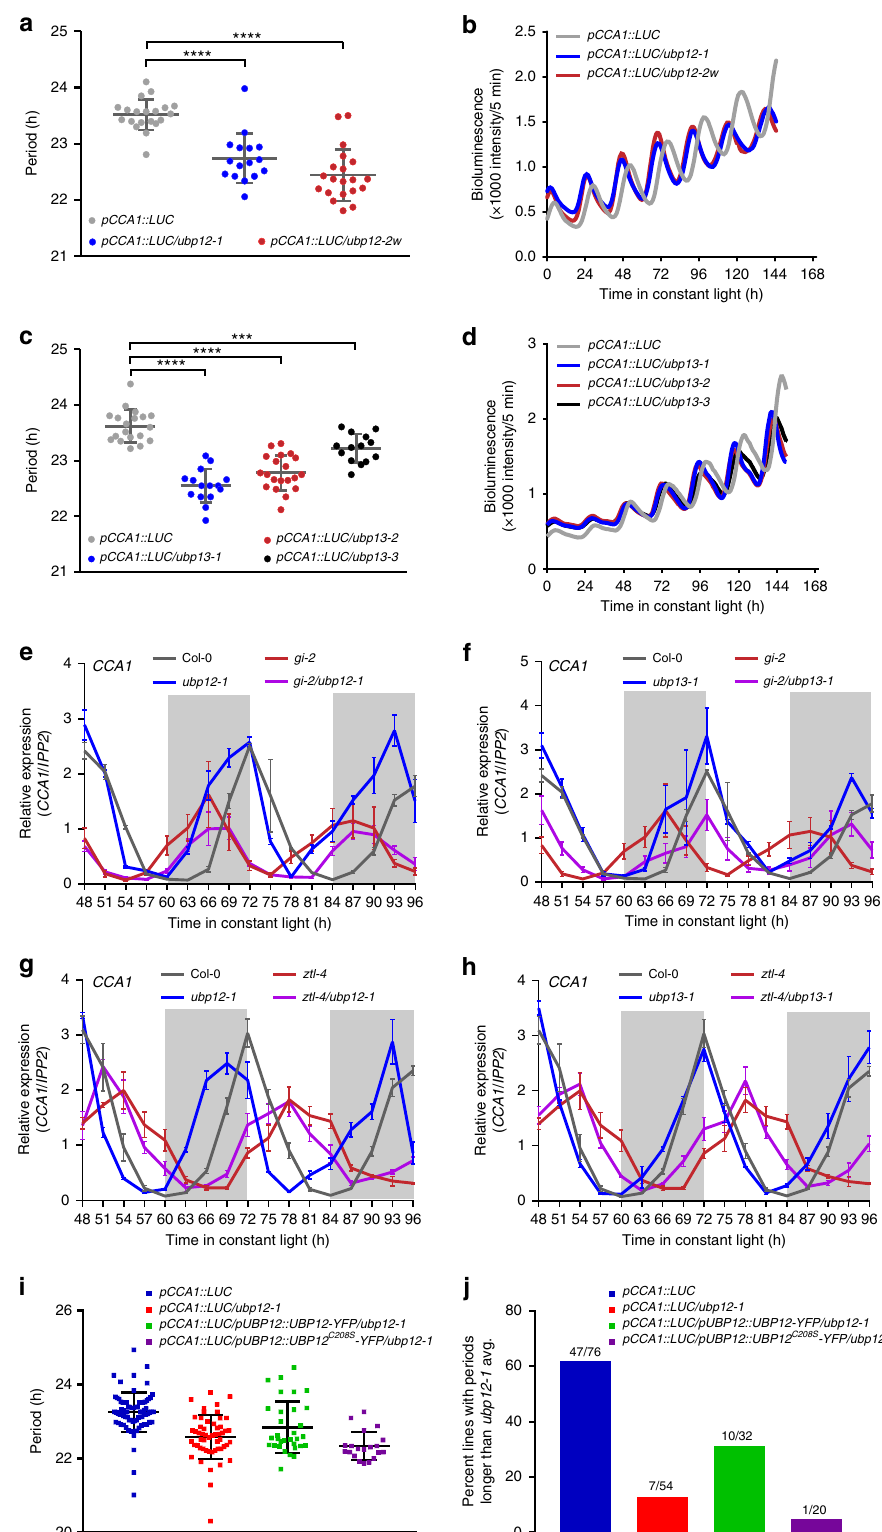
UBP13 affect TOC1 protein levels, we crossed a transgenic line expressing TOC1 fused to YFP under the TOC1 promoter ( TMG ) to the ubp12-1 and ubp13-1 mutants and measured TOC1 protein levels (Fig. 3e). TOC1 protein levels were severely reduced in